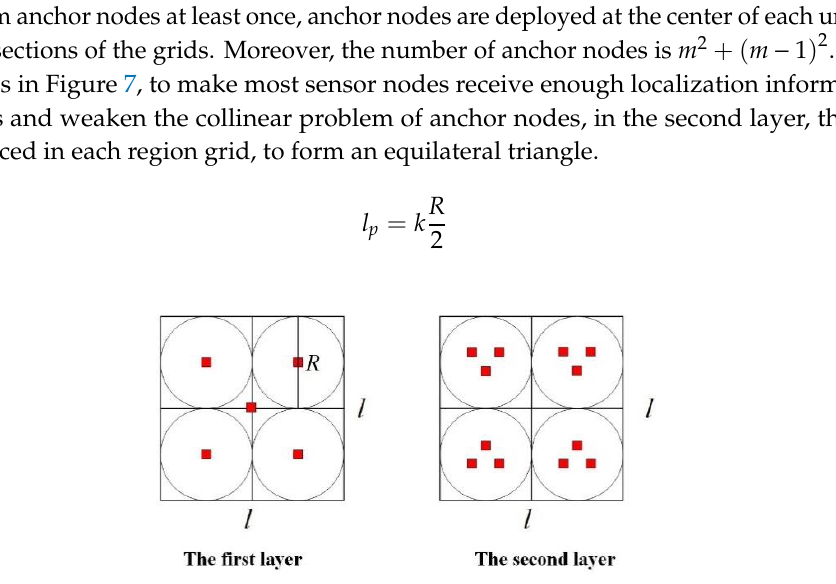
Figure 8. Deployment of anchor nodes.